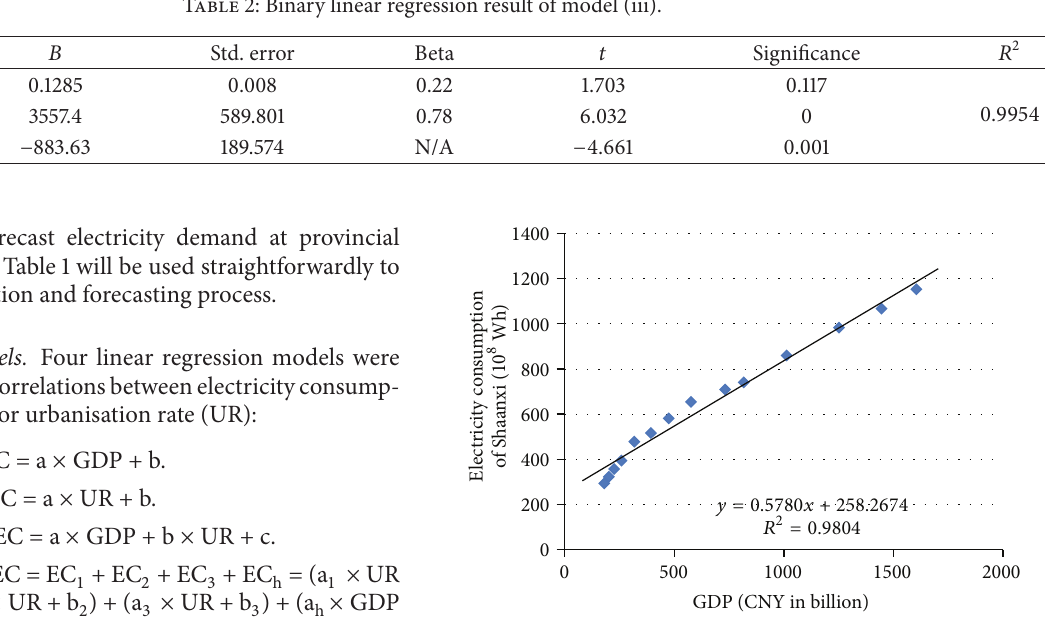
Figure 4: Unary linear regression result of model (i).